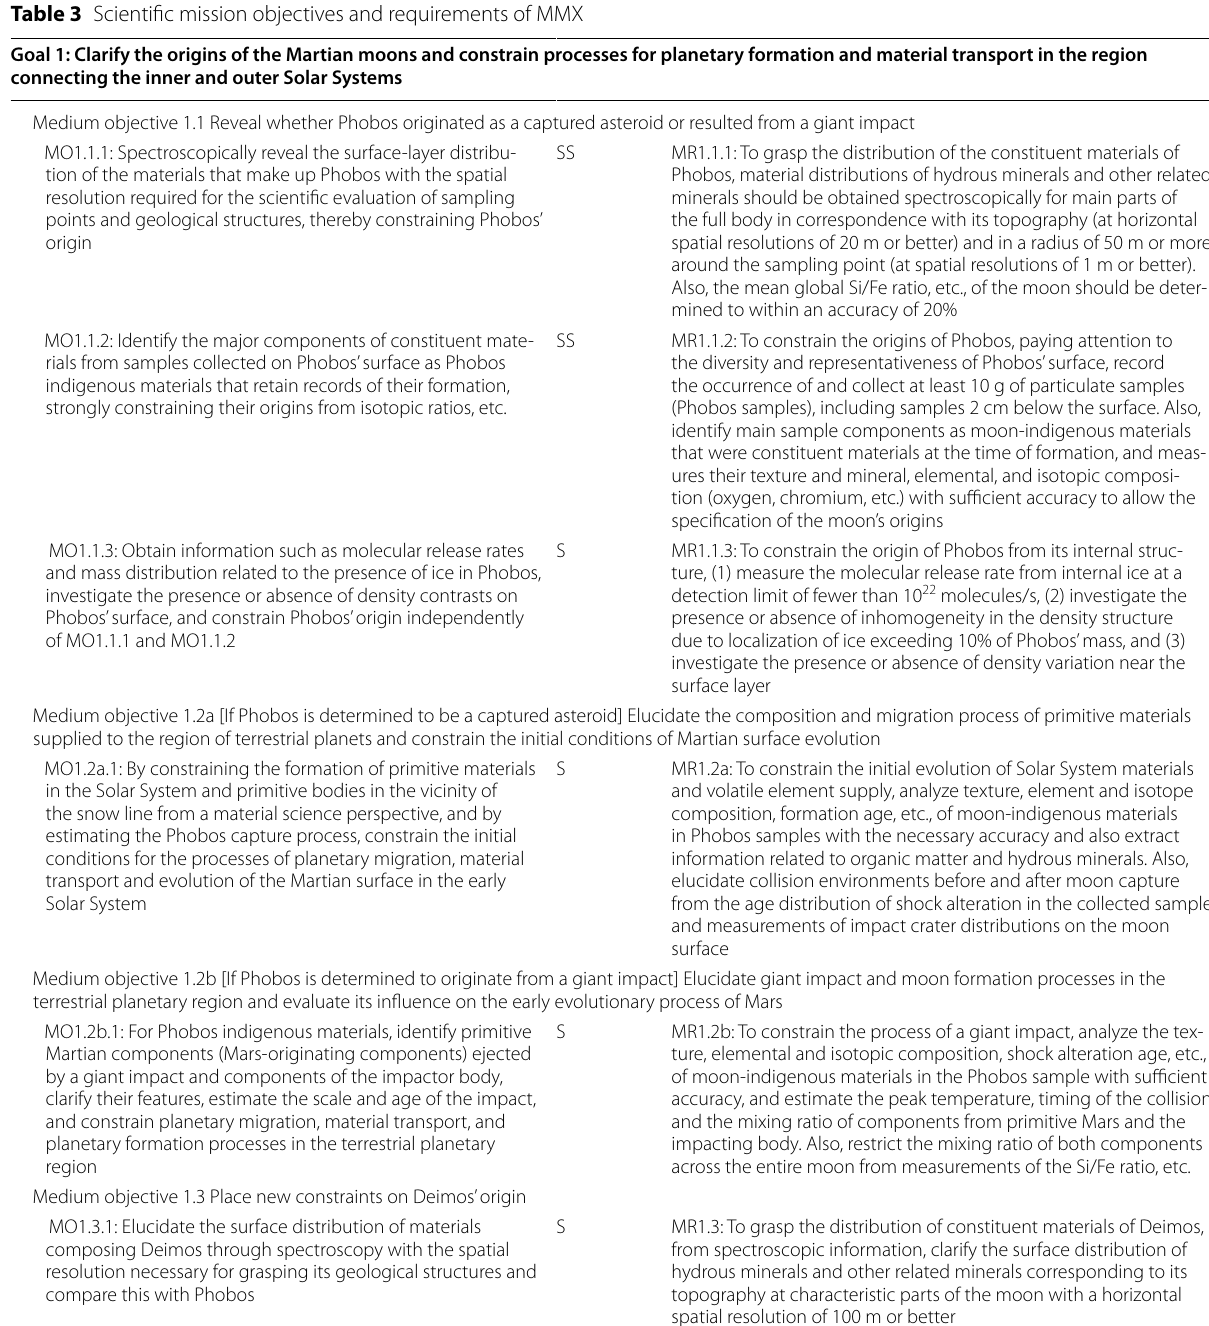
Table 3 Scientific mission objectives and requirements of